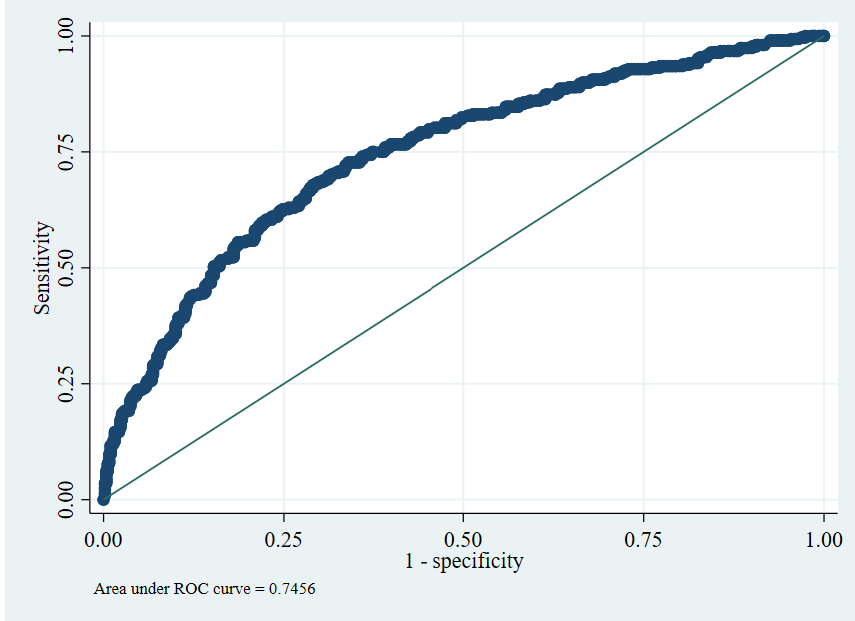
Figure 2. ROC curve presenting discriminatory ability of the prognostic model.